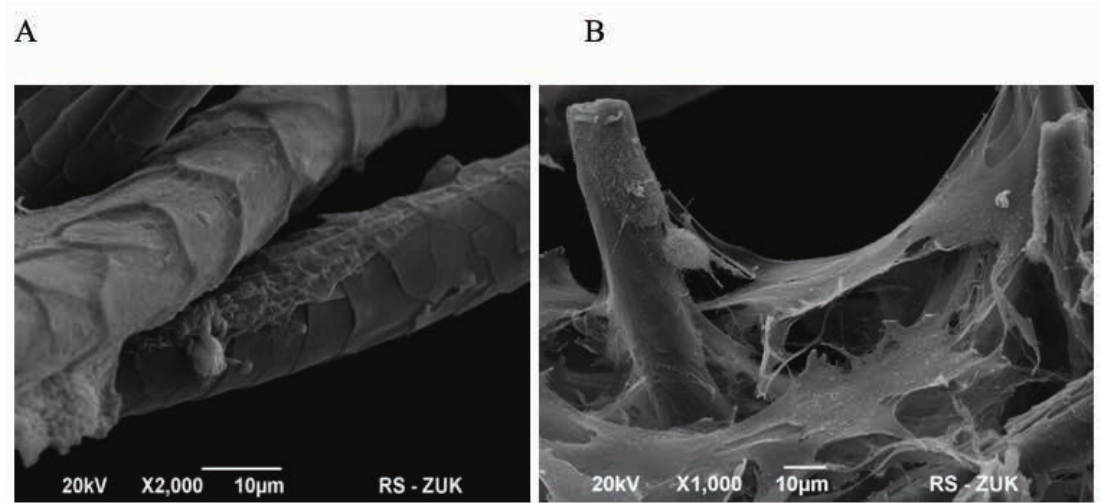
Figure 4: Scanning electron microscopic observation of the rMSC growth on F-KAPs digested with papain. (A) At first 7 days after seeding, cells adhered on the surface of F-KAPs scaffolds. (B) At 32 days, the cells supported by F-KAPs formed multilayer.